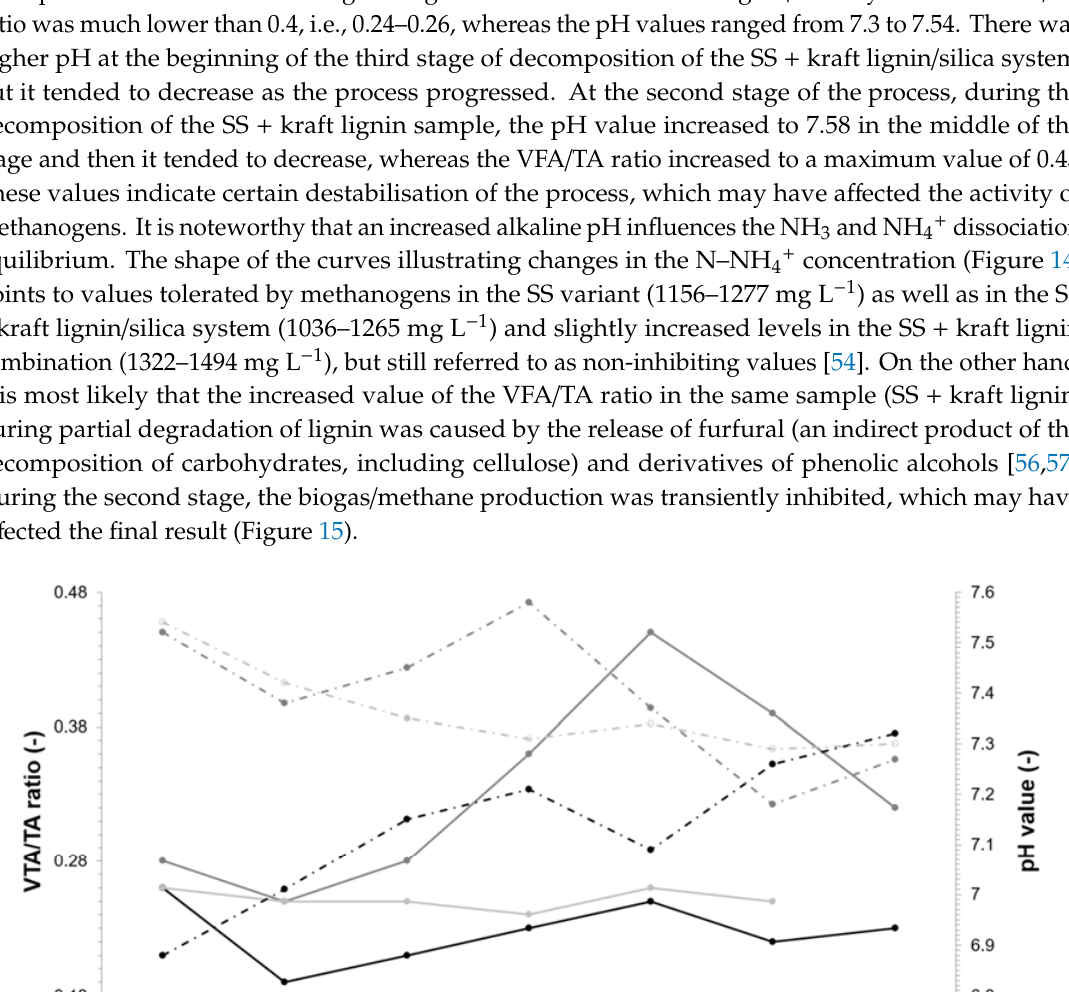
Figure 14. Changes in the N ‐ NH 4+ level during the anaerobic digestion of the SS, SS + kraft lignin and SS + kraft lignin/silica samples.